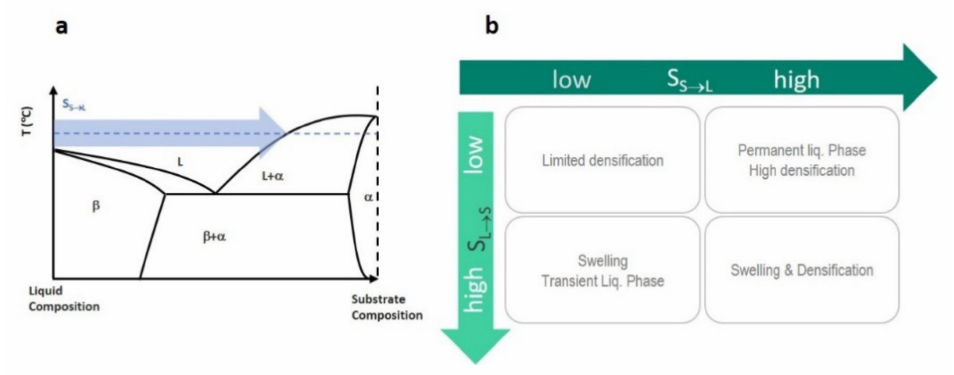
Figure 12. Solubility effects ( a ) Phase diagram representation with unipolar solubility and ( b ) rela- tionship between solubility condition and tendency to densification/swelling [62].